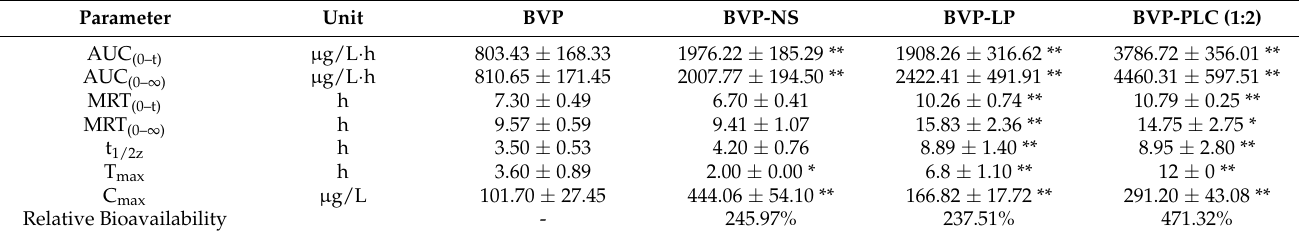
Figure 10. The plasma concentration-time curves of BVP, BVP-NS, BVP-LP and BVP-PLC (1:2) after single administration (i.g.) ( n = 5). Table 3. Pharmacokinetics parameters of BVP, nanosuspensions, liposomes and complexes (equivalent to BVP 20 mg/kg).